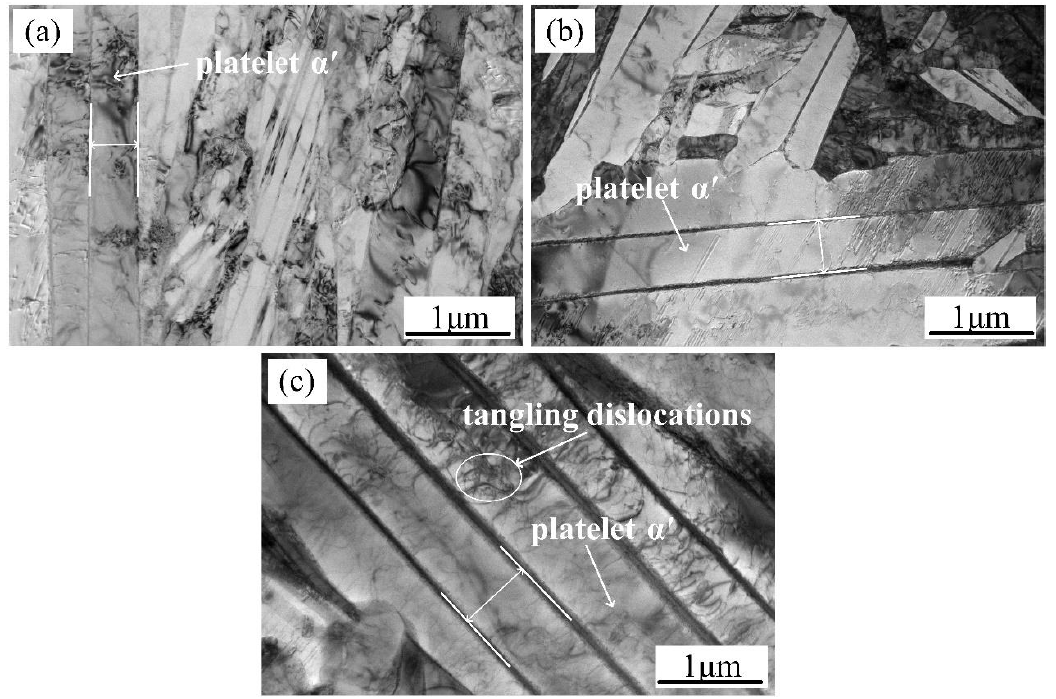
Figure 7. TEM bright field images of platelet α’ martensite at different heat inputs: ( a ) 2.2 × 10 3 J/cm; ( b ) 3.4 × 10 3 J/cm; and ( c ) 5.5 × 10 3 J/cm.